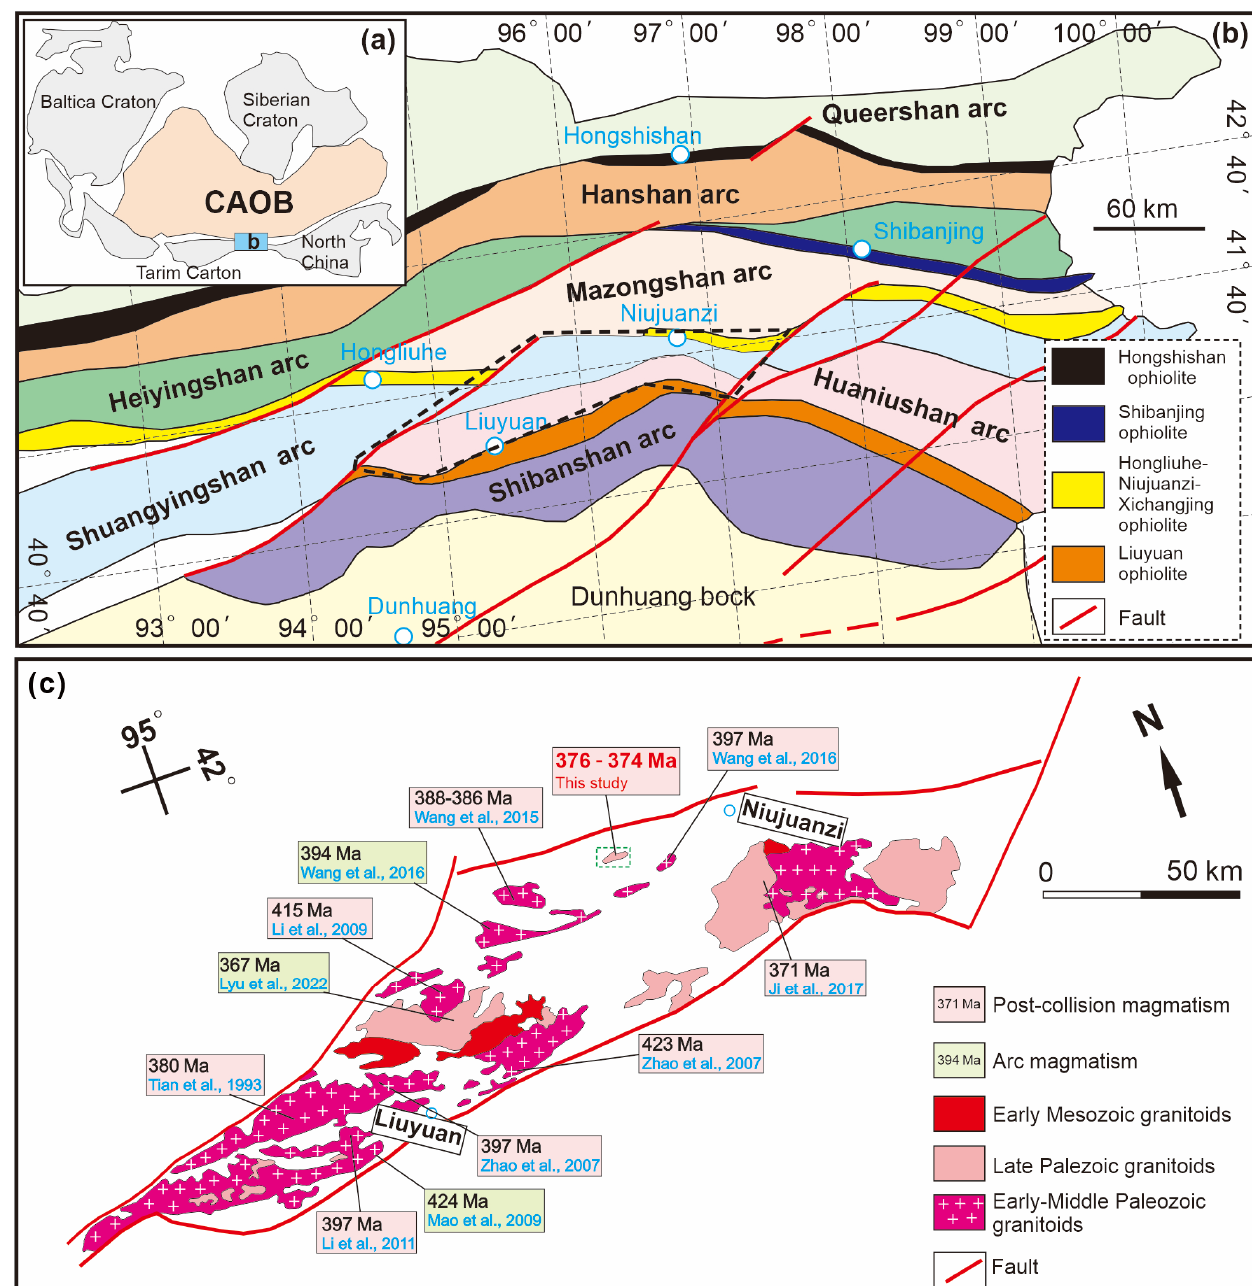
Figure 1. ( a ) Simplified tectonic map of the Central Asian Orogenic Belt showing the location of the Bieshan Orogenic Belt (BOB) [20]. ( b ) Tectonic divisions map of the BOB [20]. ( c ) Distribution of Paleozoic granitoids in the middle Huaniushan arc (modified after [21]). Figure 1c shows early Paleozoic felsic magmatism in the middle of the Huaniushan arc. The post-collision magmatism has produced A-type granites, and the arc magmatism is mostly I-type granites and adakite (age data from [15,18,22–28]).